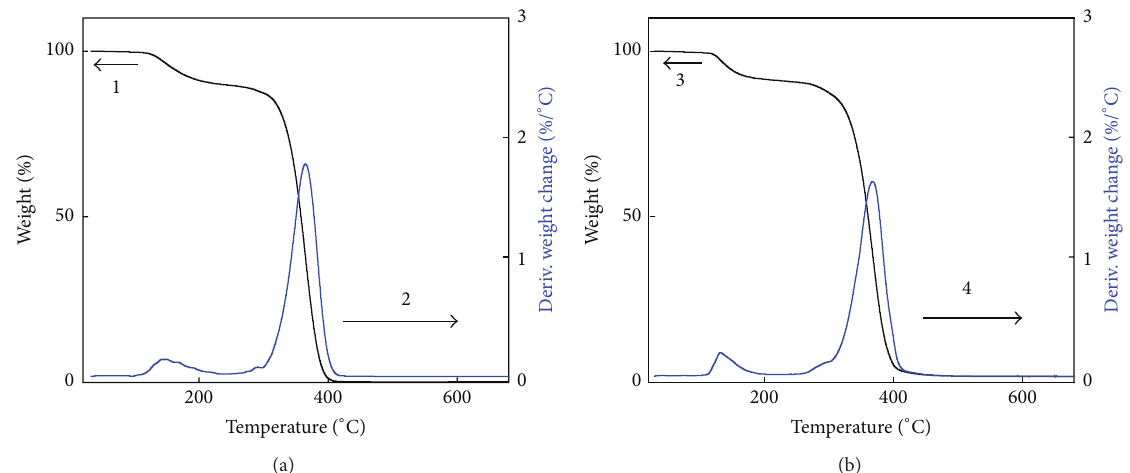
Figure 2: Thermogravimetric analysis of (a) PMMA and (b) 1wt% TBA incorporated PMMA. Curves 1 and 3 are the weight loss curves, and curves 2 and 4 are the weight loss rate curves.